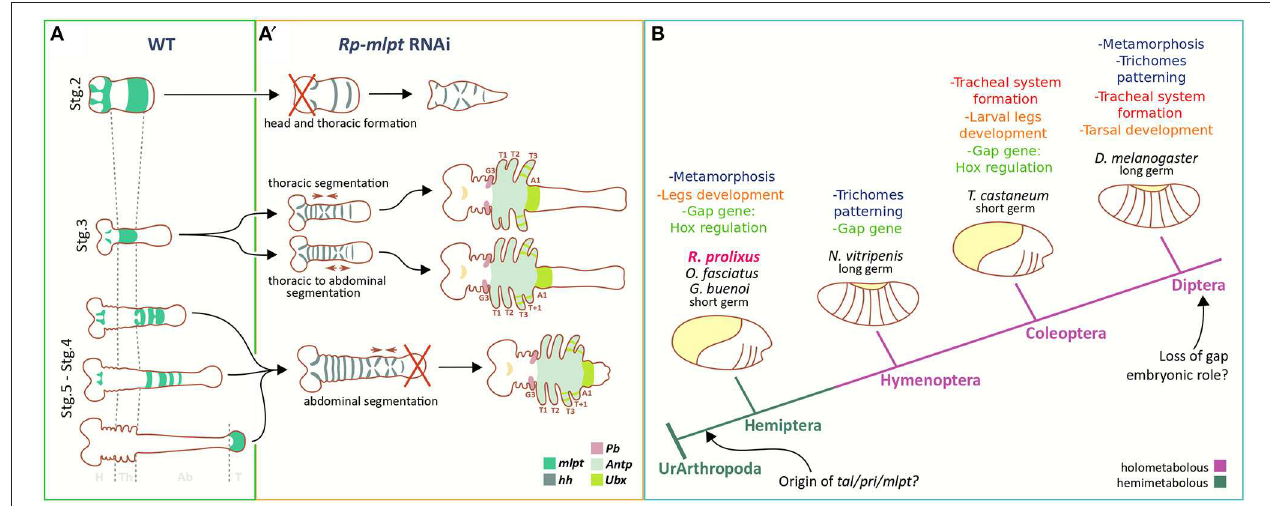
FIGURE 8 | Comparison of mlpt function in R. prolixus and other insect species. (A,A ′ ) In R. prolixus mlpt is required for the correct specification of thoracic vs. abdominal segments, patterning of the distal structures of the legs, and of head formation in strongly affected embryos. (B) Multiple roles of mlpt during insect evolution based on findings of Galindo et al. (2007), Pueyo and Couso (2011), Chanut-Delalande et al. (2014), Zanet et al. (2015), Cao et al. (2018), Jiménez-Guri et al. (2018) , Zhu et al. (2018), and Ray et al. (2019) and the current